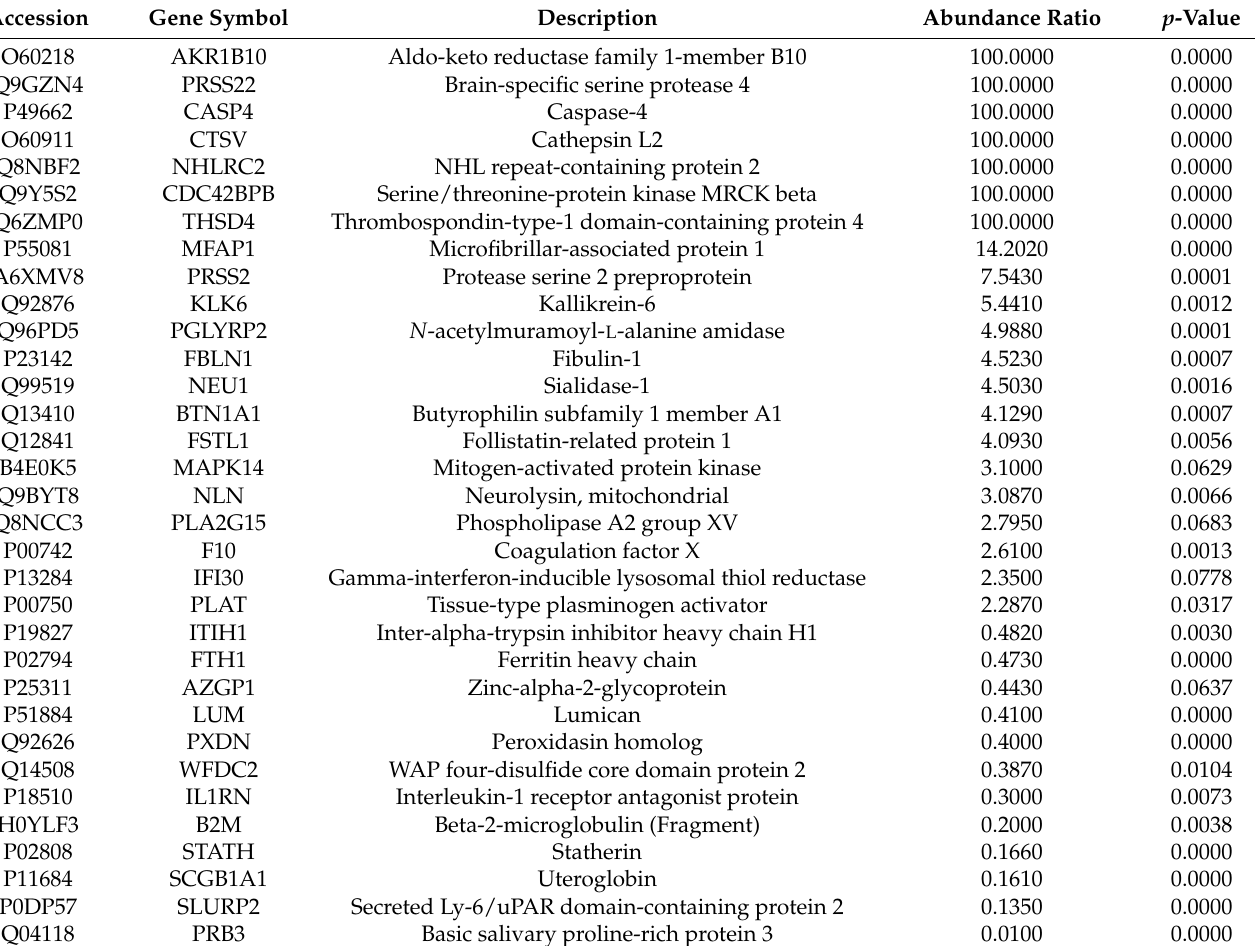
Table 1. List of the significantly quantified proteins whose “cellular component” is annotated to be “extracellular”. Each protein is reported with its accession, gene name, TVE vs. control abundance ratio, and the related p